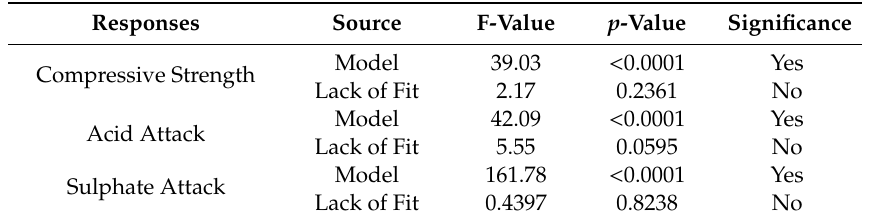
Table 7. ANOVA analysis.